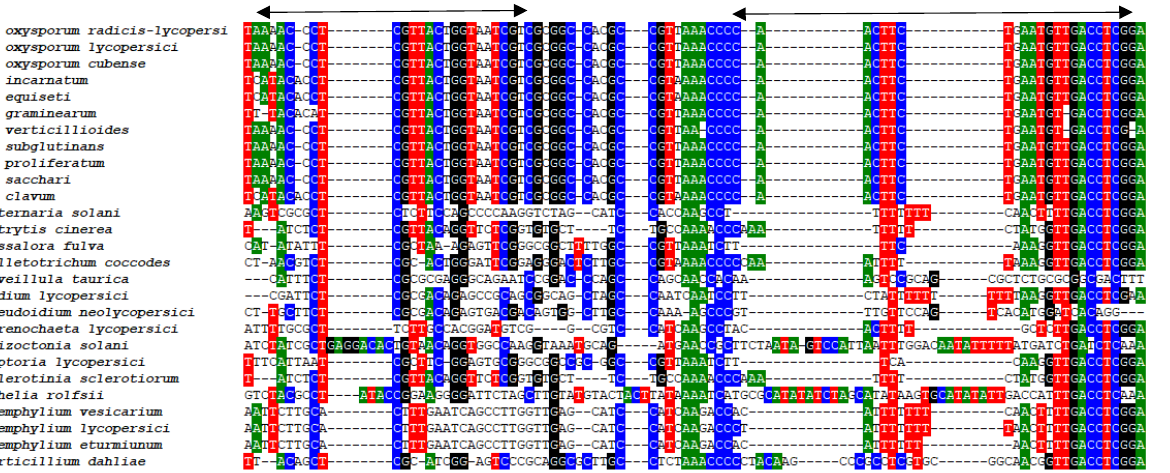
Figure 1. Multiple alignment of a partial sequence of the ribosomal internal transcribed spacer (ITS) region of nuclear rDNA of Fusarium species and other fungal species that affect tomato in the Mediterranean Basin. Arrows indicate the location of the primers used on qPCR. Accession numbers to published se- quences in the GenBank are as follows: F. oxysporum f. sp. radicis-lycopersici (MH865886.1); F. oxysporum f.